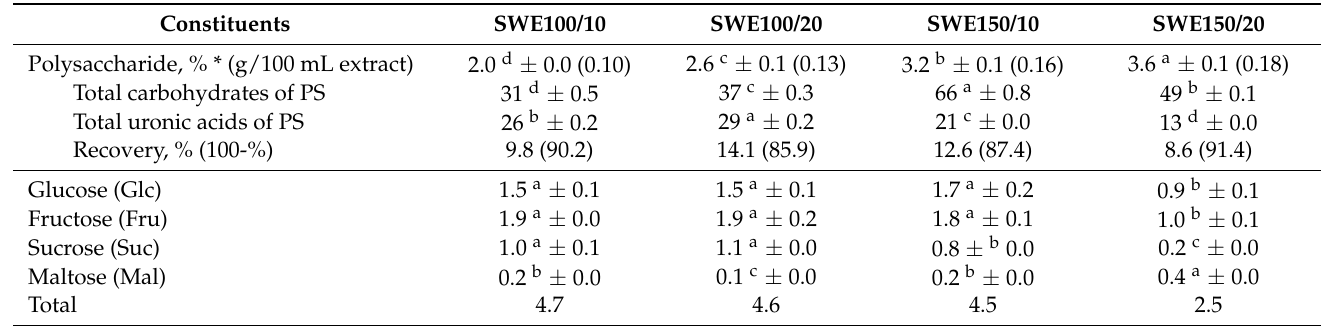
Table 4. Polysaccharide content and sugar composition of lemon balm subcritical water extracts ( w / w